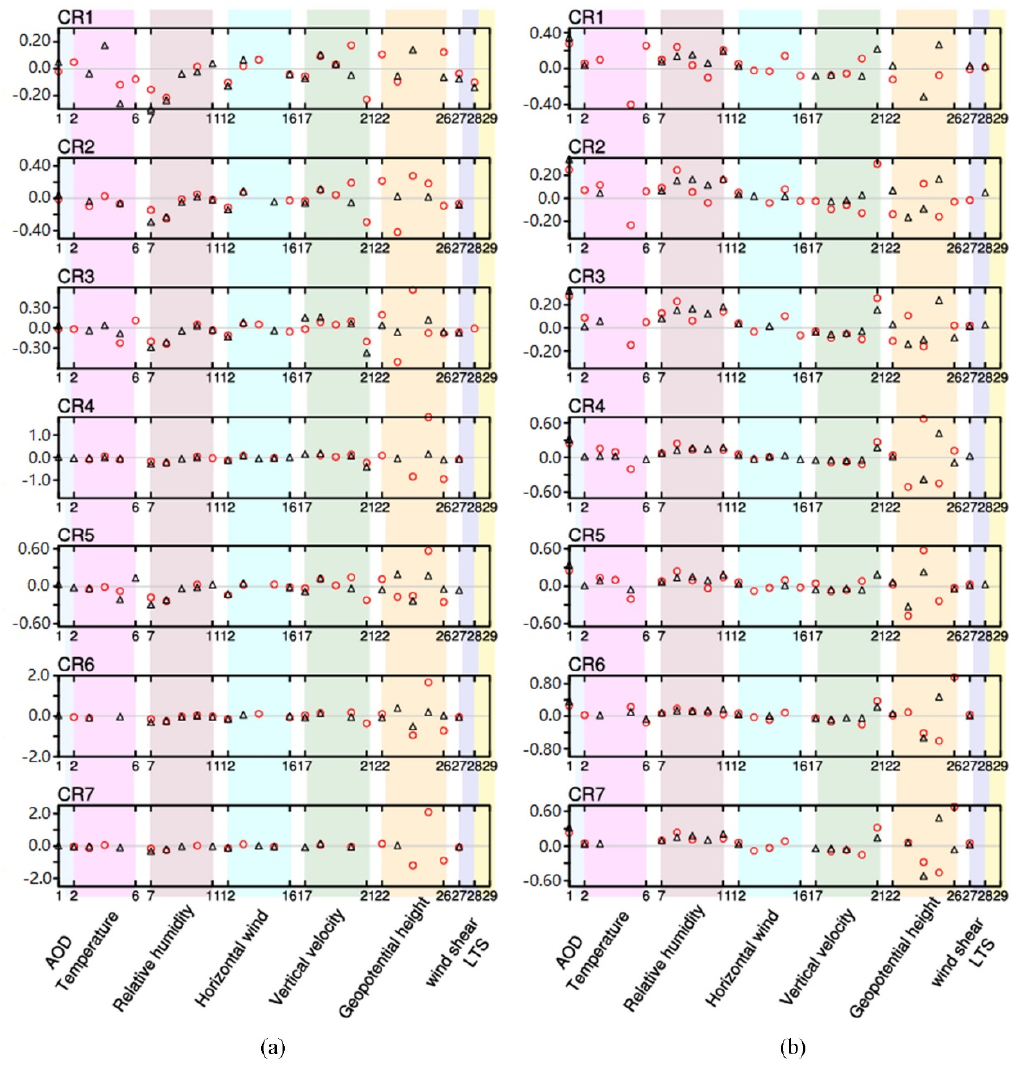
Figure 10. The multivariable linear regression between ( a ) CTP, ( b ) TCC and AOD and meteorological variables. In the order from top to bottom are results for seven cloud regimes (CR1–CR7). Black triangles represent results in eastern China while red circles represent results in western China. The missing data are variables that did not pass the significance test at the level of 0.05. The abscissa values are 1 for AOD, 2–6 for temperature, 7–11 for horizontal wind, 12–16 for relative humidity, 17–21 for vertical velocity, 22–26 for geopotential height at 200, 500, 700, 850, and 1000 hPa, respectively, 27 for wind shear, and 28 for LTS.